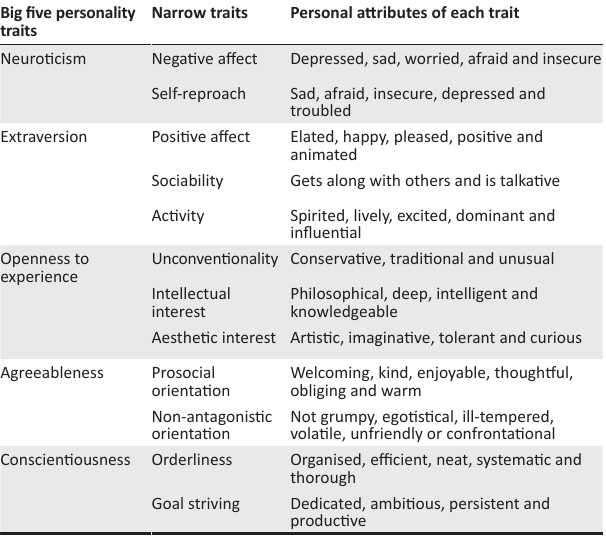
TABLE 1: Neuroticism, Extraversion, Openness five-factor inventory narrow traits. Big five personality